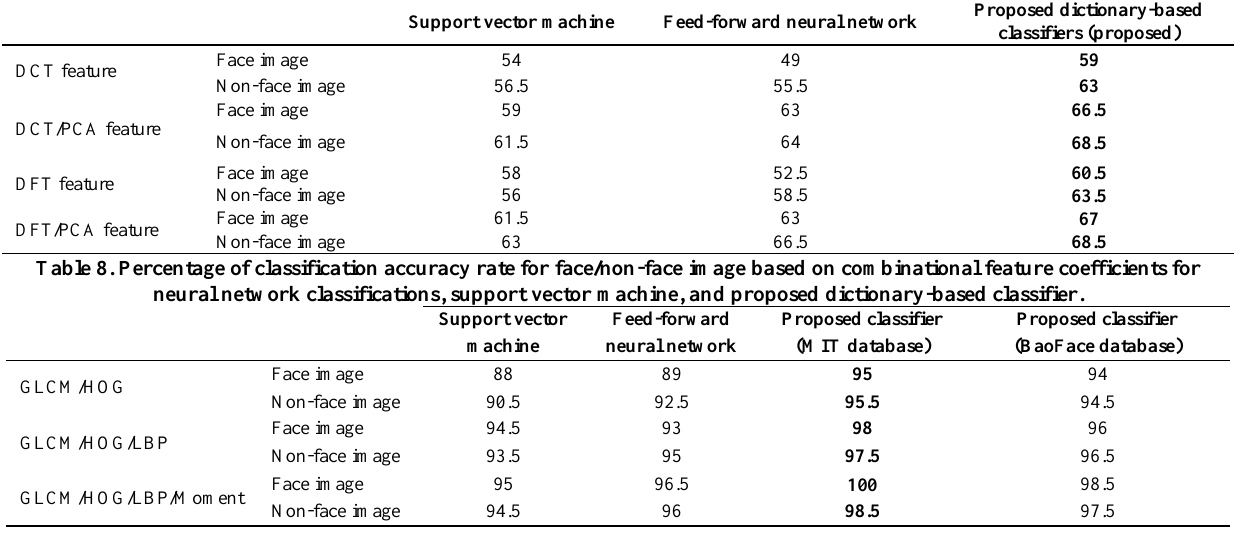
Table 7. Percentage of classification accuracy rate for face/non-face image based on DFT and DCT coefficients as well as these coefficients in combination with PCA algorithm for neural network classifications, support vector machine, and proposed dictionary-based approach.